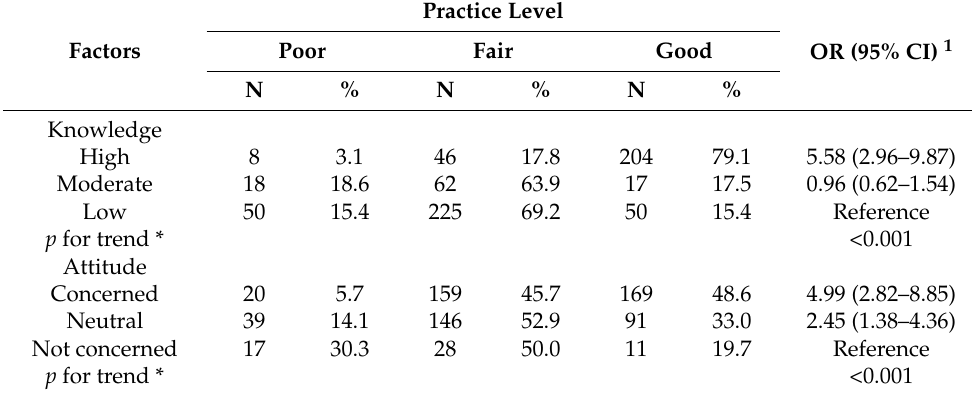
Table 4. Associations between knowledge, attitude, and practice level (N = 680).